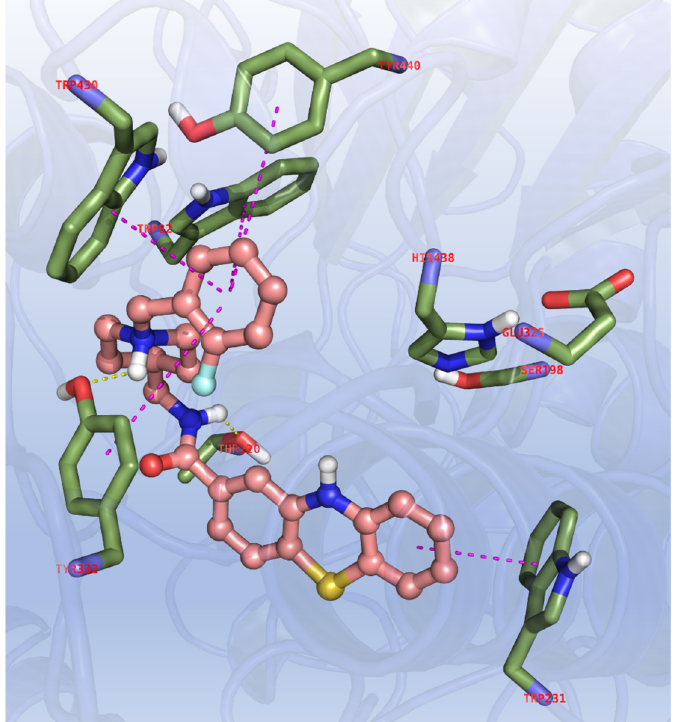
Figure 4. Binding mode for 11d to the BChE active site. In the interaction pattern scheme hydrogen bonds and π - π stackings are depicted in yellow and magenta, respectively.